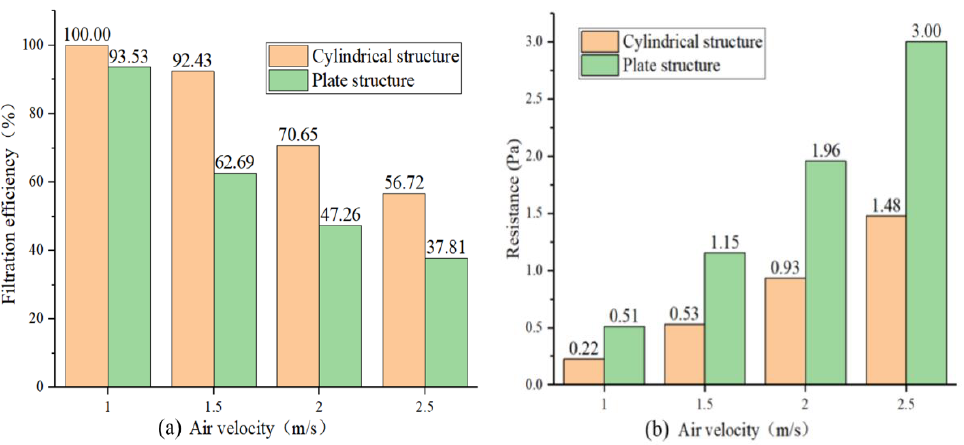
Figure 9. The filtration performance of the two types of micro-electrostatic filters: ( a ) the filtration efficiency of the two types of micro-electrostatic filters for 0.1 μm particles at different air velocities; ( b ) the single channel resistance of the two structures.